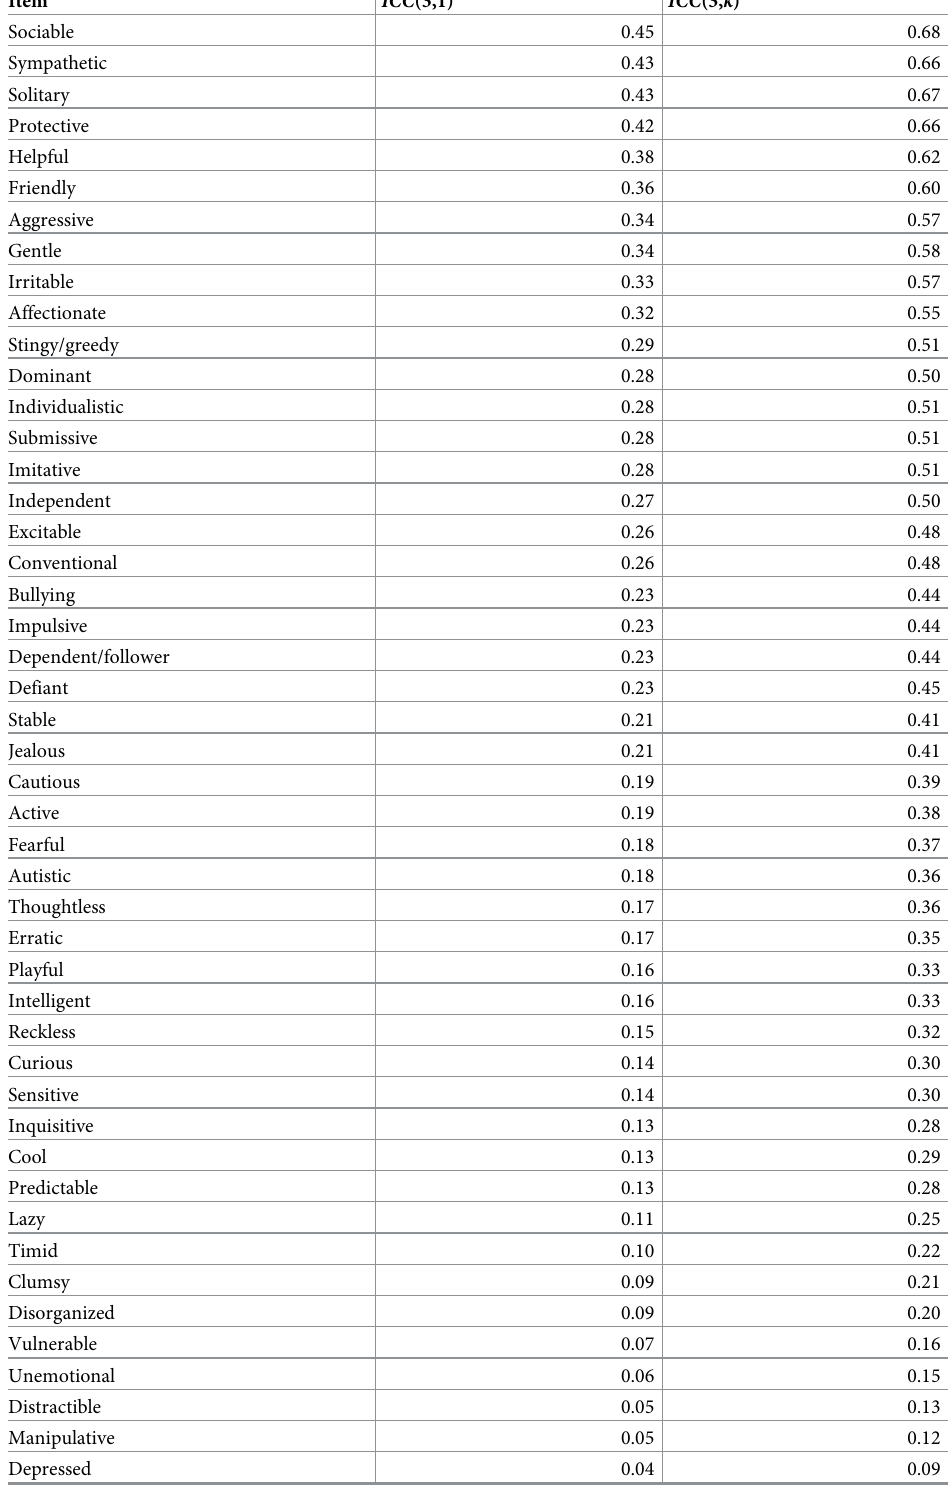
Table 2. Interrater reliabilities of items from the Hominoid Personality